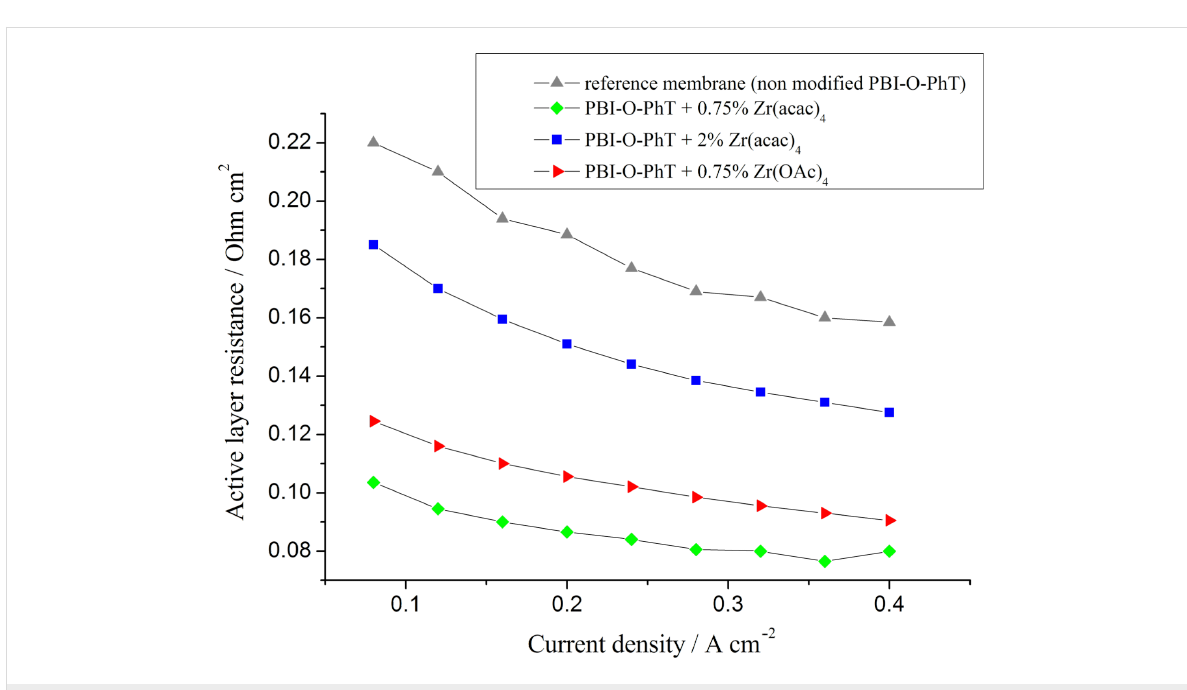
Figure 11: Distributed cathode active layer resistances as functions of current density for fuel cells with different PBI membranes. T = 160